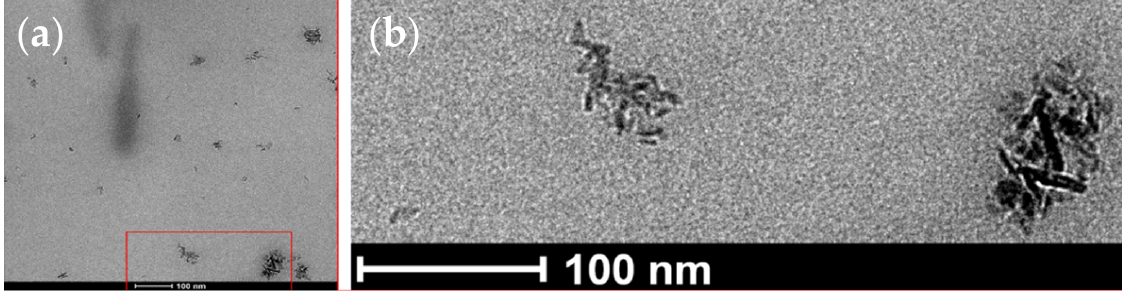
Figure 10. ( a ) TEM micrograph showing the morphology of the aggregates found in the 5 wt.% nanocomposite and ( b ) magnified image of the area marked in red.